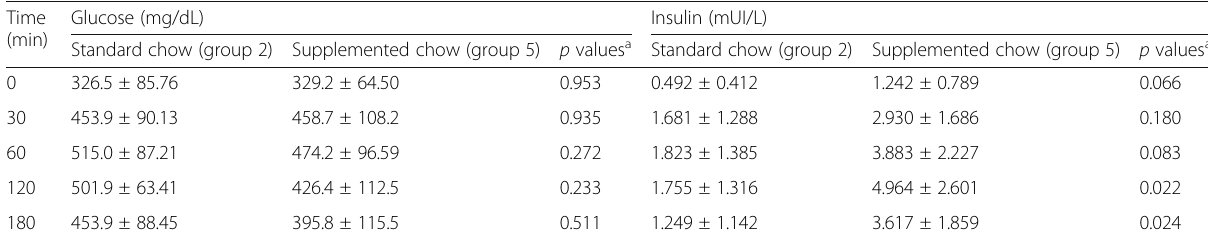
Table 4 Glucose and insulin concentrations obtained after the administration of an oral 3 g glucose load to diabetic rabbits ( n = 6) treated with an oral metformin dose of 30 mg/kg Time Glucose (mg/dL) Insulin (mUI/L) (min)